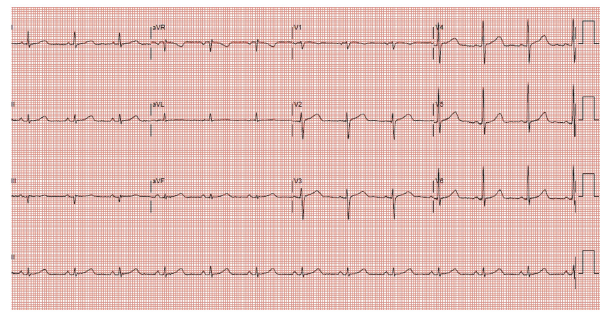
Figure 2: Patient A. Sinus rhythm, ventricular rate 75, and postcon- version.